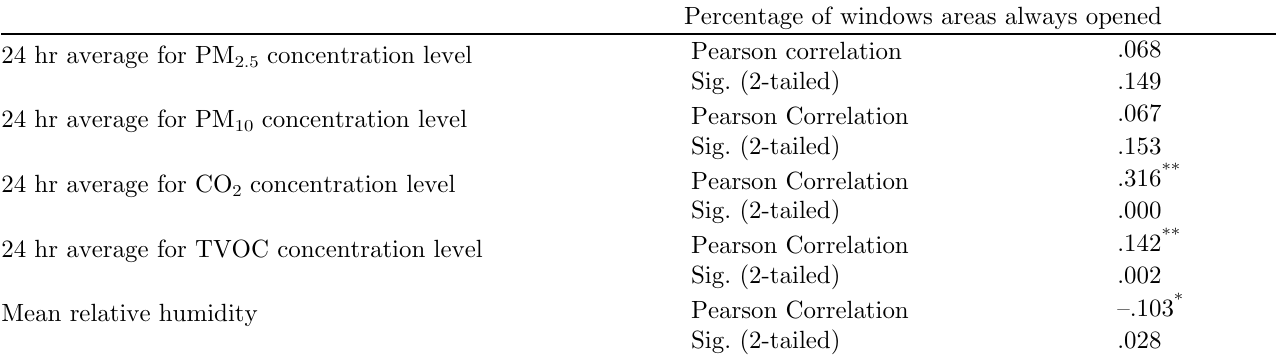
Percentage of windows areas always opened